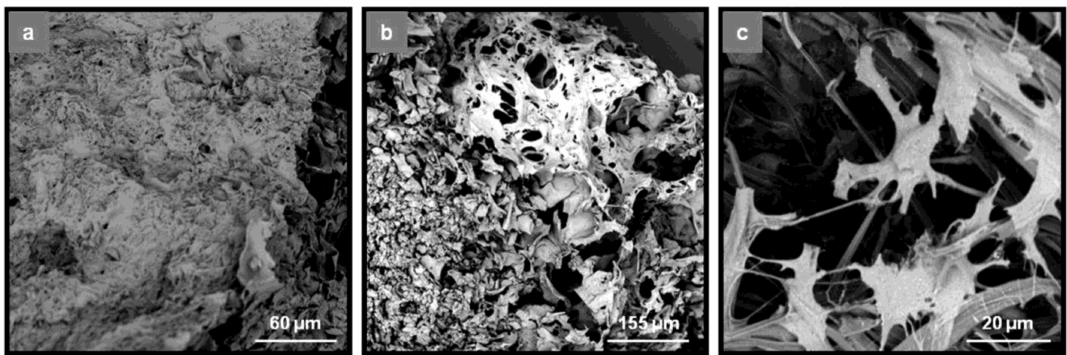
Figure 9. SEM images of UG(B) sca ff olds seeded with hADMSCs, depicting the adhesion and spreading of hADMSCs inside the porous structure of the sca ff olds after 21 days culture in osteogenic di ff erentiation medium. ( a ) UG(B)3:7; ( b ) UG(B)5:5; and ( c ) magnification of UG(B)5:5 showing the